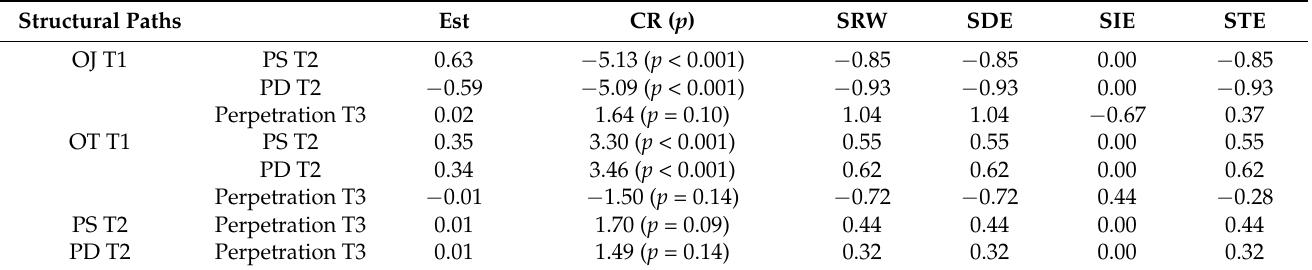
Table 4. Estimates, critical ratios, and standardized direct, indirect and total effects of the hypothe- sized